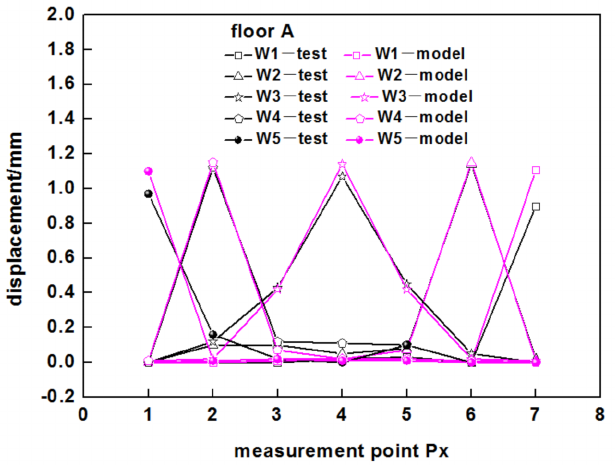
Figure 12. Experimental and modeled results of deflections of Floor A under W series point loading.